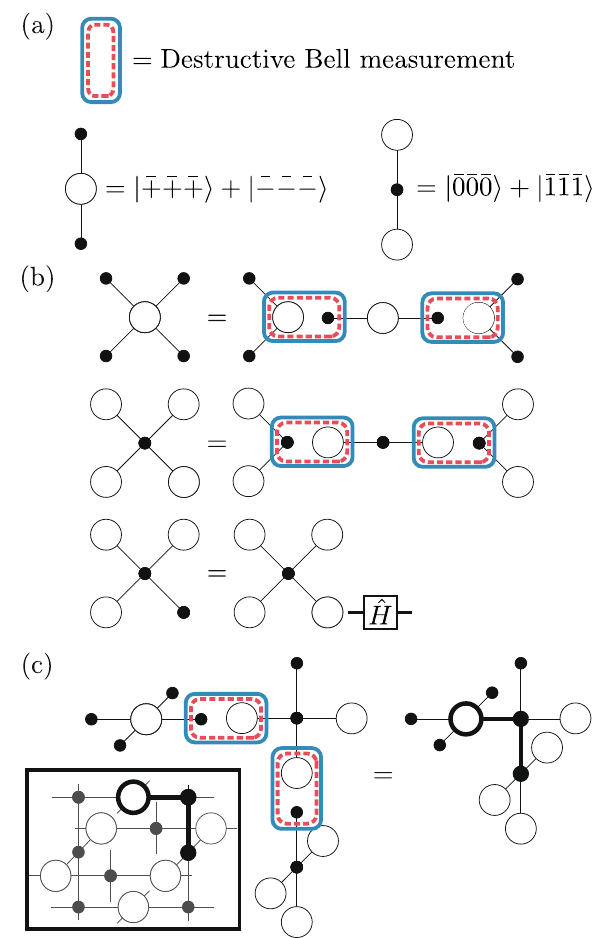
Fig. 5 Building the XZZX cluster state with fusion measurements. a The XZZX cluster state can be built from three-qubit GHZ cluster (cid:2) (cid:2) ffiffiffi ffiffiffi (cid:3) (cid:3) p p (cid:2) (cid:2) 2 2 states ð 000 using only and ð þþþj i þ (cid:3)(cid:3)(cid:3)j iÞ = þ 111 Þ = destructive Bell measurements. b Larger fi ve-qubit cluster states built from the three-qubit cluster states. When fusing small cluster states using Bell measurements, the measurement outcomes determine Pauli corrections we must apply to get the correct fi nal state. Importantly, a Z error on a qubit involved in a Bell measurement only results in an erroneous Z correction on the fi nal cluster state, so that Bell fusions are bias-preserving. Note that to get the third cluster state, we apply a Hadamard ^ H to one of the qubits. This converts Z errors to X errors on that qubit, but does not result in X errors on the fi nal XZZX cluster state. c The fi ve-qubit clusters can be fused with Bell measurements to form the XZZX cluster state. Here, we illustrate the fusion measurements for the three qubits highlighted in the